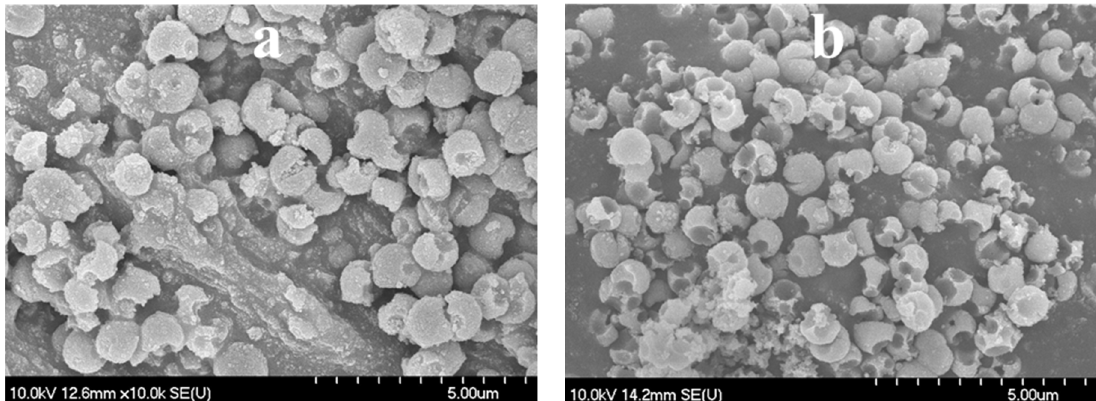
Figure 8. SEM micrographs of the H2_HS_5 ( a ) and H2_HS_6 ( b ) samples.